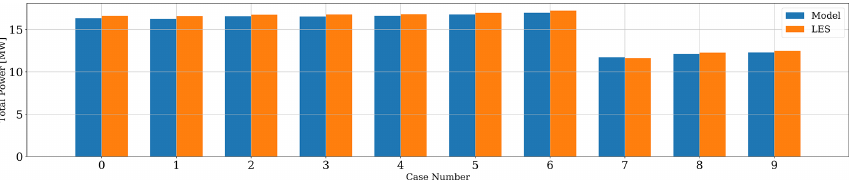
Figure 6. Total power output for wind plant LES with wake steering compared with the model proposed.